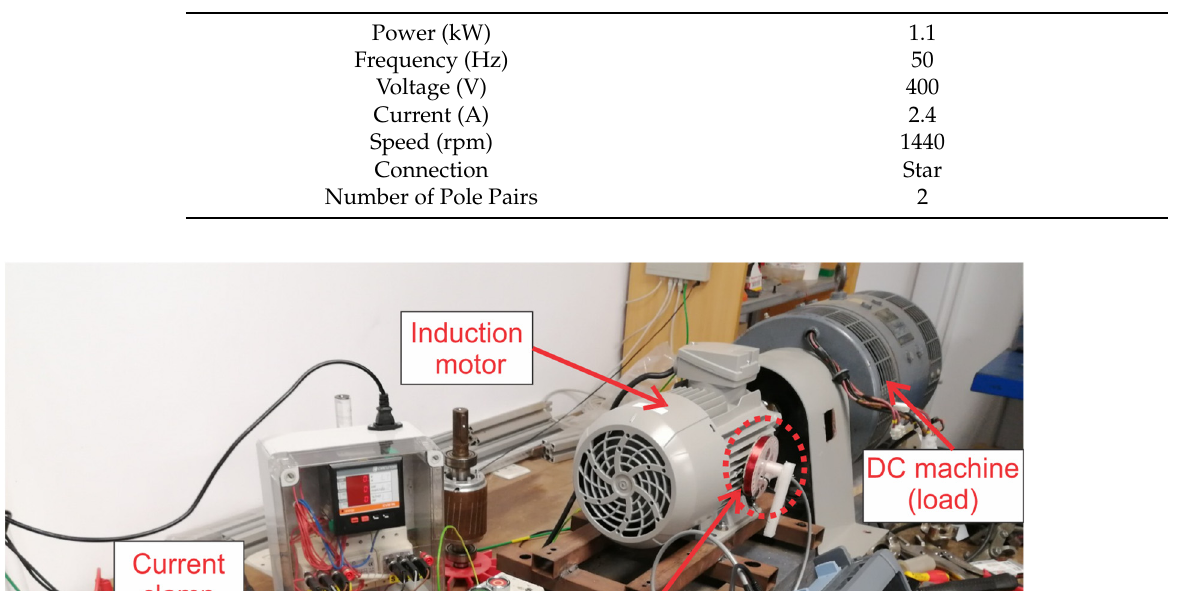
Table 1. Rated values and characteristics of the driving induction motor.